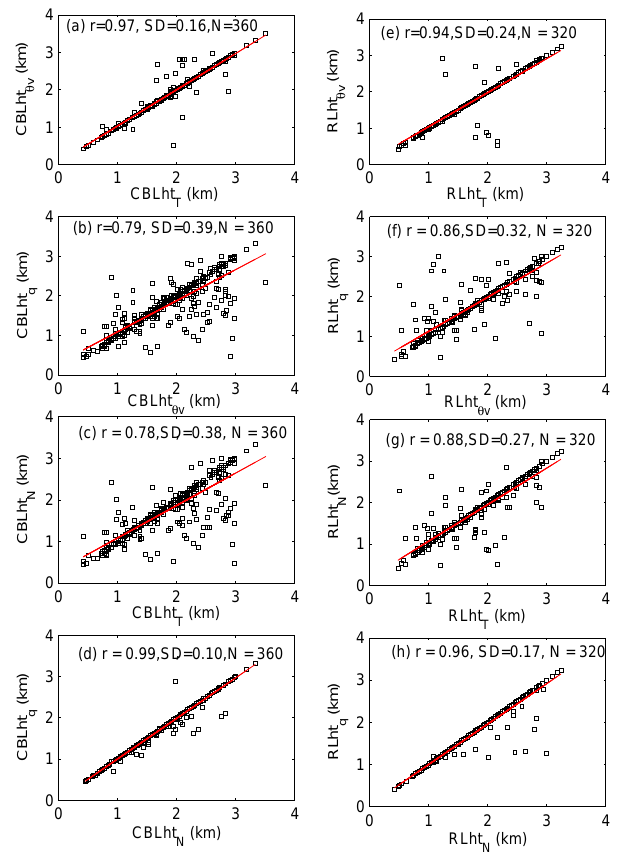
Figure 5. Scatter plot between the CBL heights obtained using (a) T and θ v , (b) θ v and q , (c) T and N , and (d) N and q . (e–h) are same as (a–d) but the RL